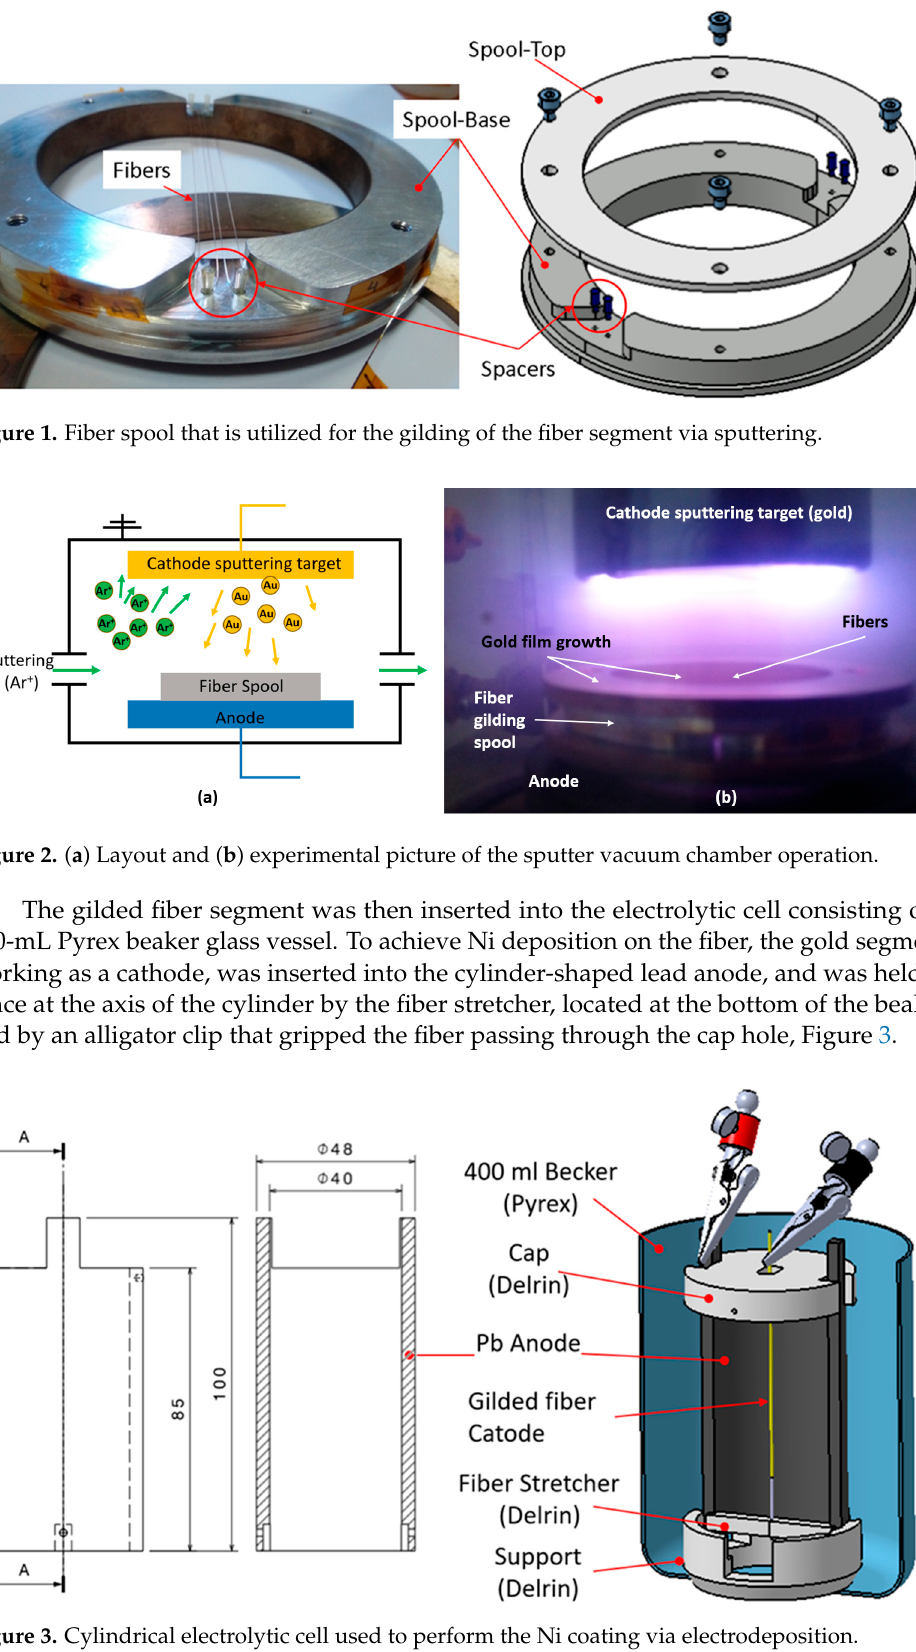
Figure 3. Cylindrical electrolytic cell used to perform the Ni coating via electrodeposition.